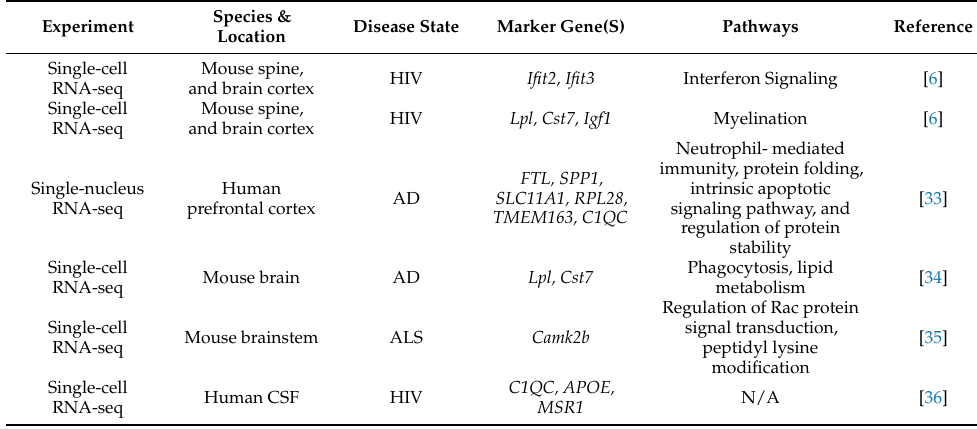
Table 1. Summary of findings identified from microglial RNA sequencing